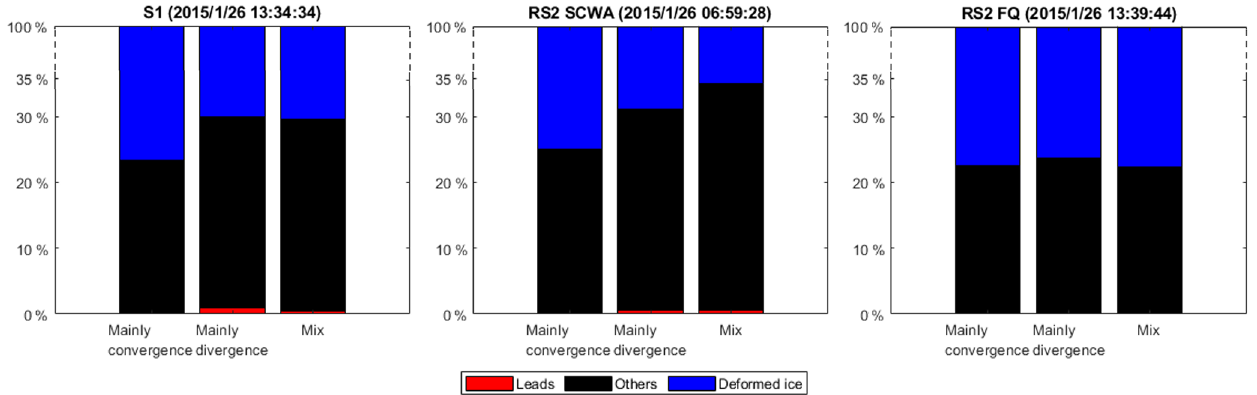
Figure 11. Areal fractions of different classes (three-class scheme) within deformation parcel